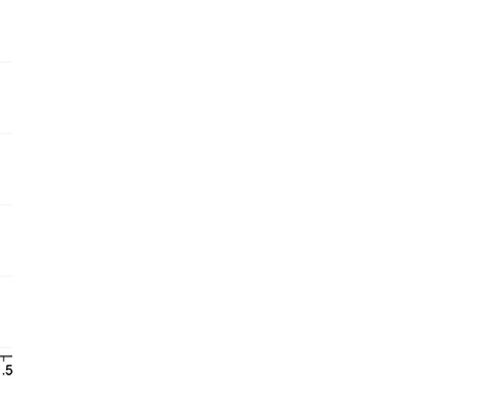
Figure 7. Funnel plot of pooled correlations between FA and consciousness in the CC. To draw the funnel plot, correlation coefficient values were converted into Fisher’s z values which fitted normal distribution. SE, standard